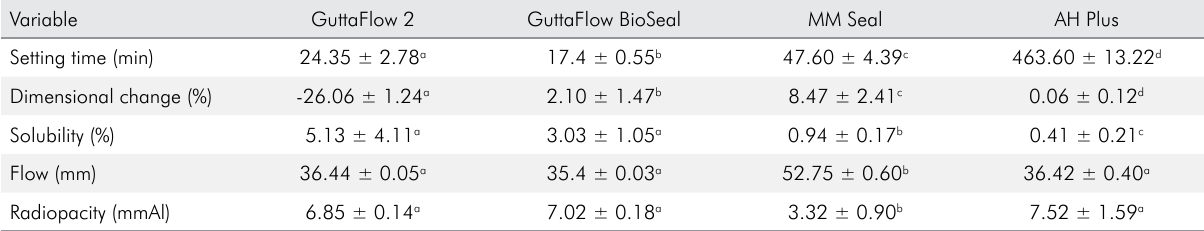
Table 2. Physicochemical properties of GuttaFlow 2, GuttaFlow Bioseal, MM Seal, and AH Plus (mean ± SD).